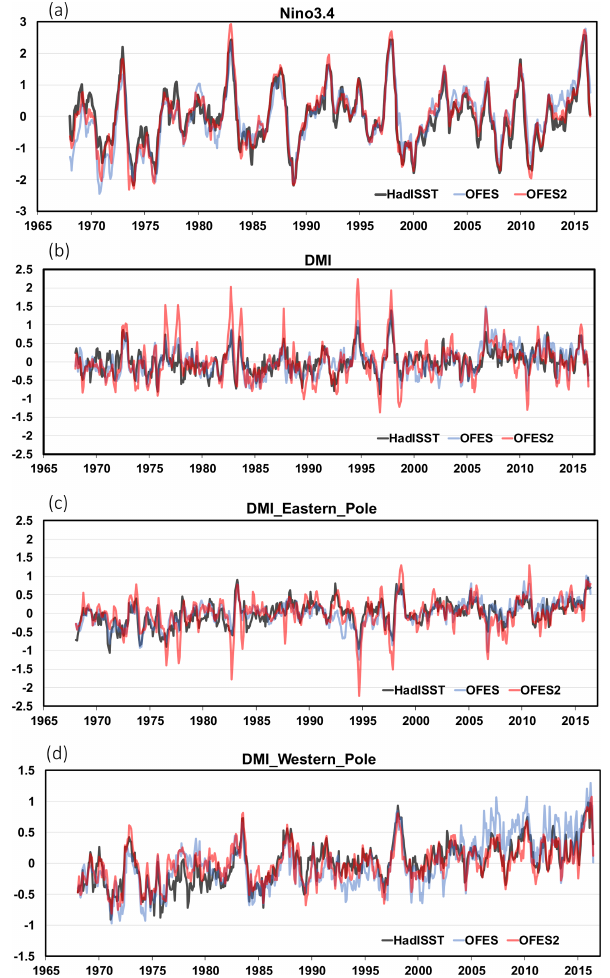
Figure 10. (a) Monthly Niño3.4 index defined as SSTAs ( ◦ C) at 165–145 ◦ W and 5 ◦ S–5 ◦ N in the eastern topical Pacific. (b) The monthly DMI ( ◦ C) defined as the difference between the SSTAs ( ◦ C) at the (c) eastern (90–110 ◦ E, 10 ◦ S–0 ◦ ) and (d) west- ern (50–70 ◦ E and 10 ◦ S–10 ◦ N) poles (Saji et al., 1999) from OFES2 (red curve), OFES (blue curve), and HadISST version 1 (black curve; http://www.cpc.ncep.noaa.gov/data/indices/ last ac- cess: 15 July 2020 and